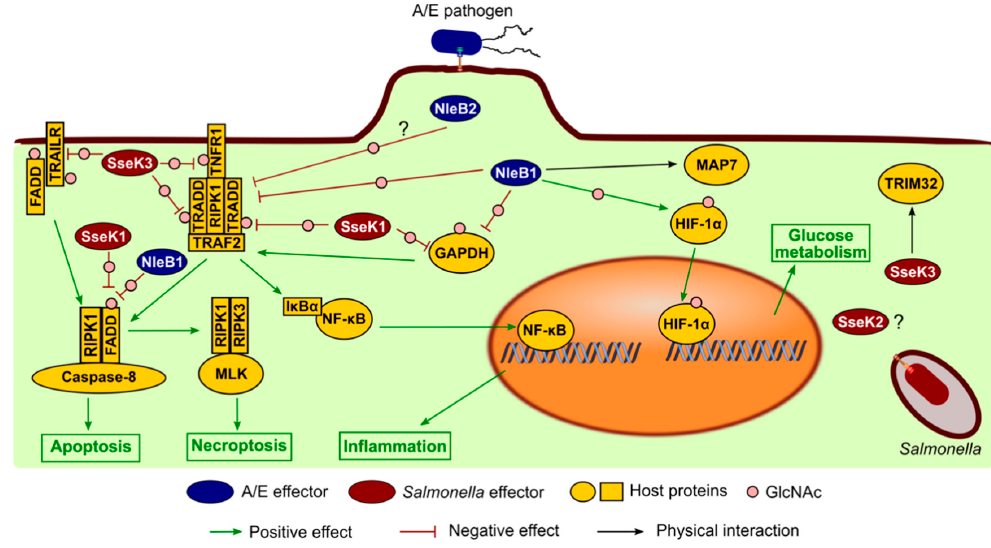
Figure 6. Summary of NleB/SseK host protein targets.